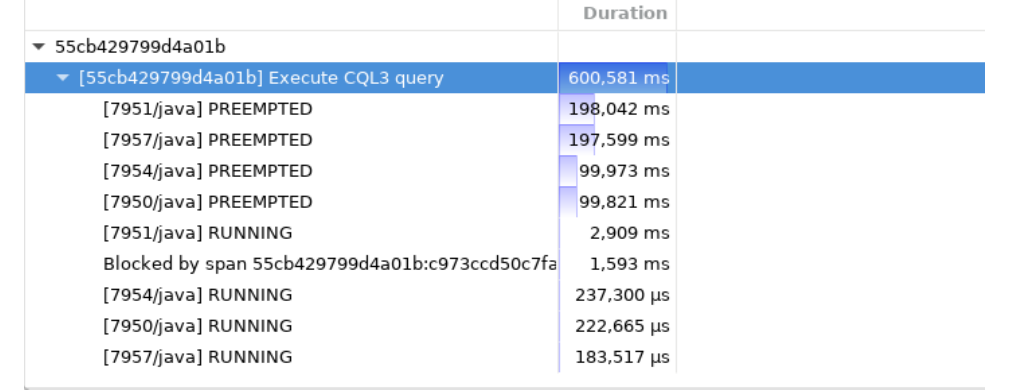
Figure 16. Use case: summary of a critical path. The critical path summary shows that request